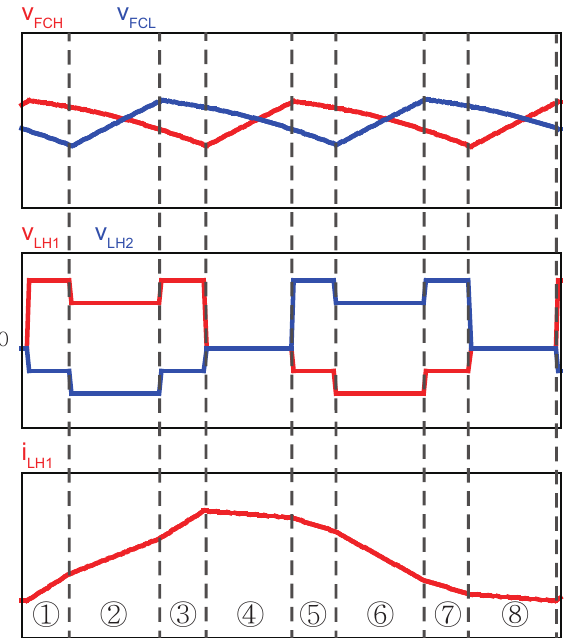
Figure 14. Waveforms observed when N-type interleaving is performed on a TLBC as an open loop.